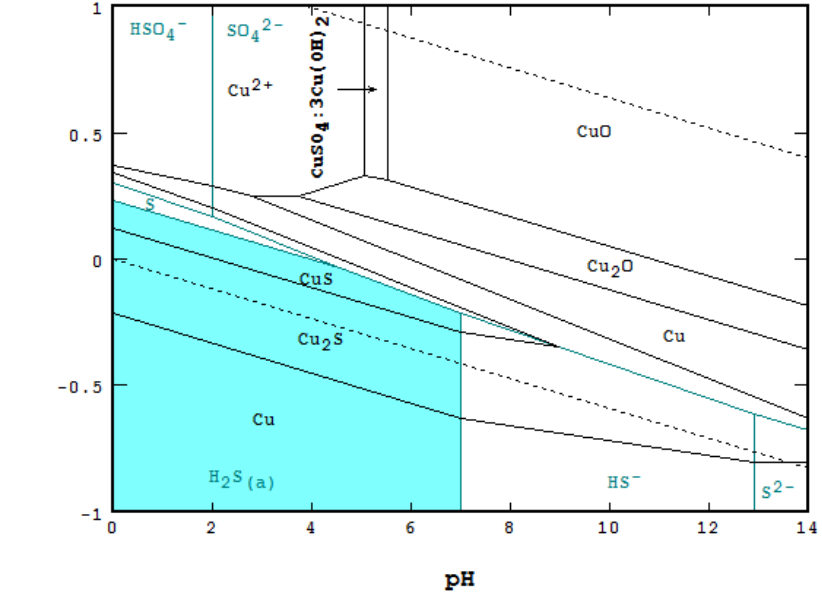
Figure 10. Eh-pH of Cu(main)–S (ligand). The line method plots the ligand first, shown in blue color. The distribution of Cu species for each domain of S is then determined.